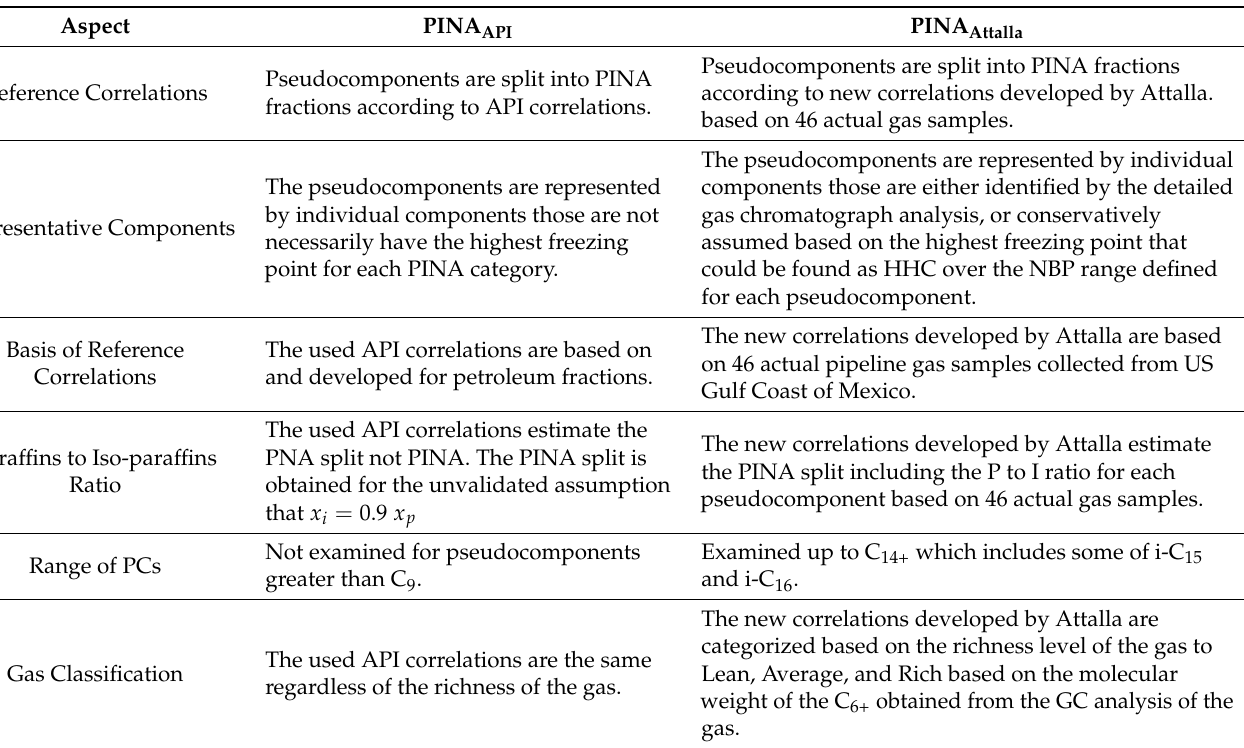
Table 14. Summary of the differences between the PINA API and the PINA Attalla